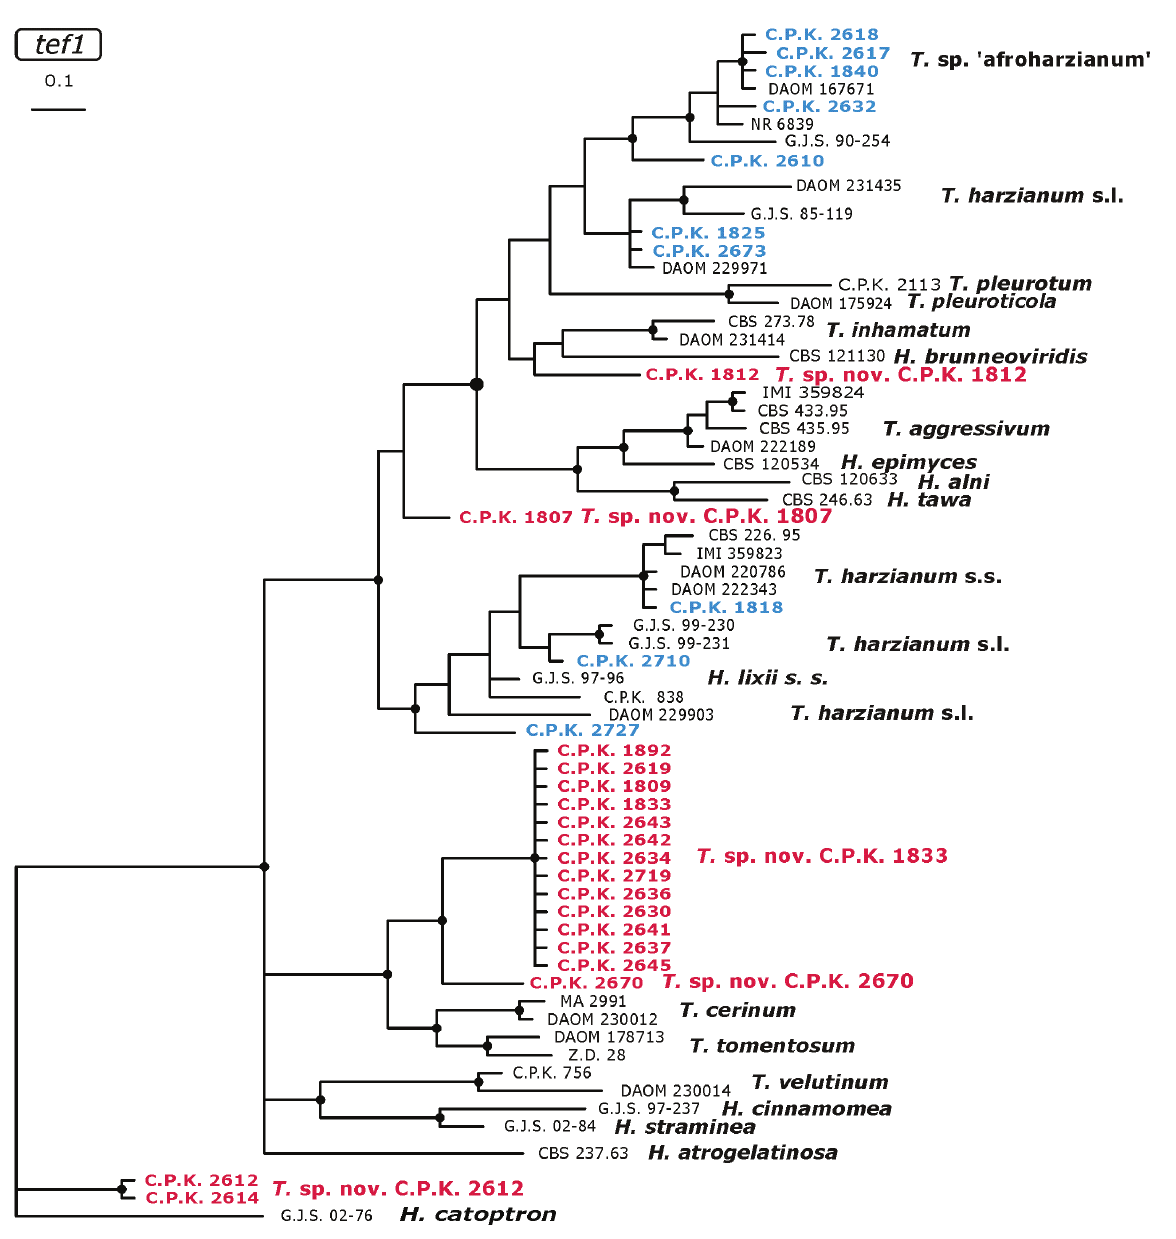
Figure 5. Distribution of Ethiopian Trichoderma strains within Harzianum clade as inferred from a Bayesian analysis of tef1 intron showing the position of potentially new species (red) and hypothetically endemic populations (blue). Nodes marked by black circles indicate posterior probabilities >0.94. GenBank accession numbers of the corresponding tef1 sequence of the reference strains are given in